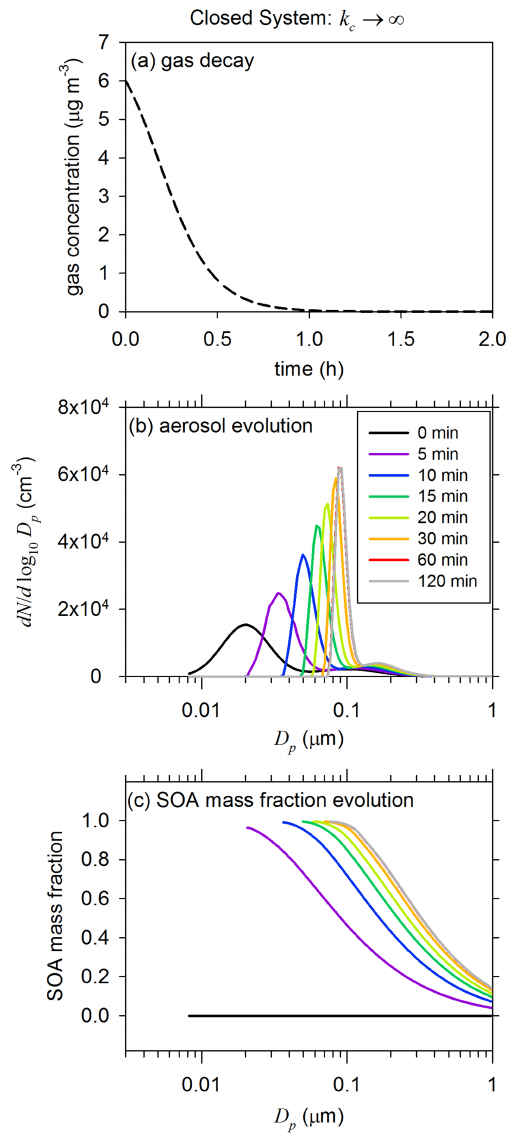
Figure 12. Results for the instantaneous reaction reference case ( k c → ∞ ; equivalent to nonvolatile solute condensation): (a) gas- phase concentration decay, (b) temporal evolution of aerosol size distribution, and (c) temporal evolution of the mass fraction of newly formed